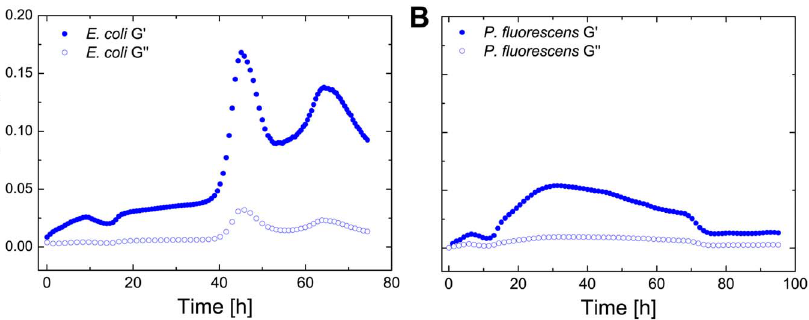
Figure 4. Transient biofilm elasticity of E.coli and P.uorescens . The elastic (G0) and viscous (G00) as a function of time for E. coli (A) and P. fluorescens (B).